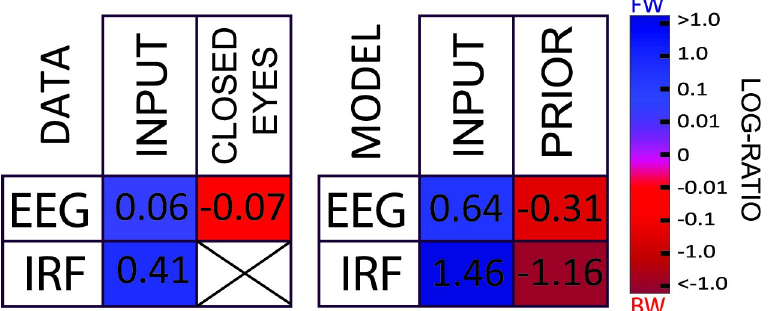
Fig 5. Summary of the results. The tables summarize the results of the data (left) and simulation (right) for each dataset/condition. In each situation, the average log ratio is presented numerically as well as color-coded. Red and blue squares indicate respectively a higher incidence of BW and FW waves. (As explained previously, it is not possible to compute an IRF in the CLOSED EYES condition.) All data are available at